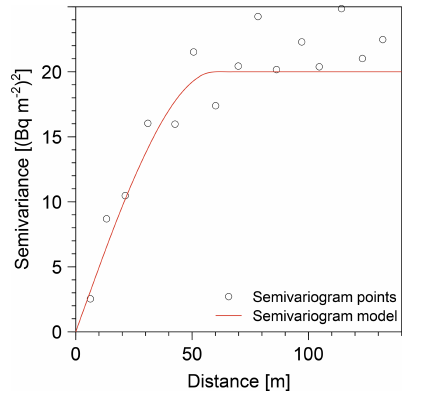
Figure 2. Semivariogram and semivariogram model fit of the 239 + 240 Pu block kriging